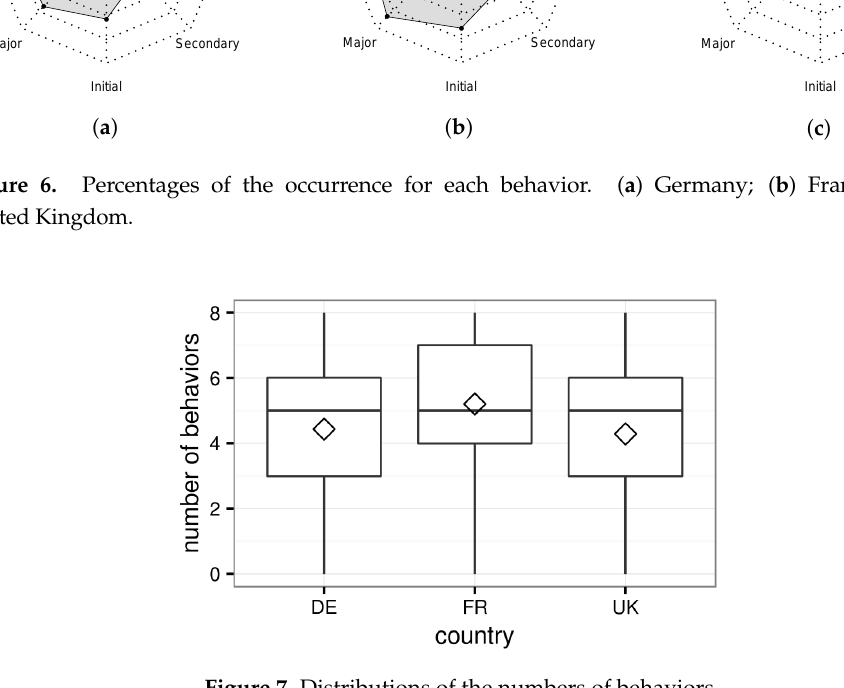
Figure 7. Distributions of the numbers of behaviors.